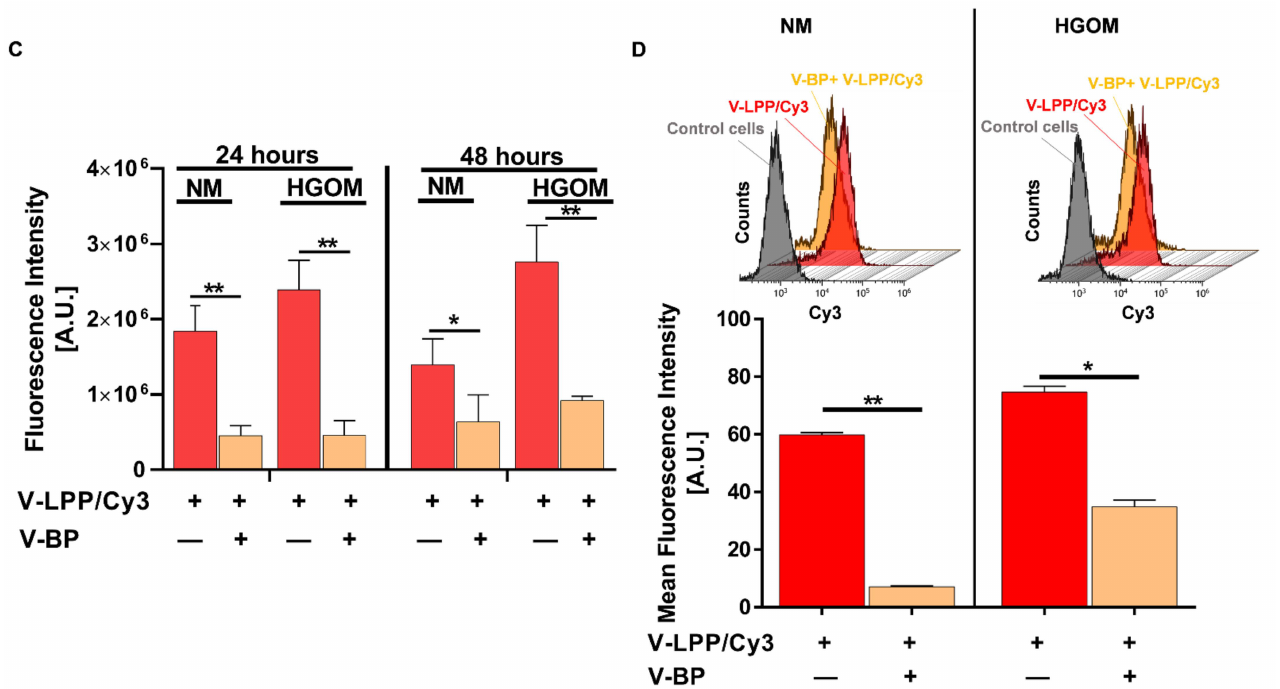
Figure 4. ( A ) VCAM-1 expression on VIC surface. Percentages of VCAM-1 positive cells as de- termined by flow cytometry experiments on VIC cells cultured in normal medium (NM) or high glucose osteogenic medium (HGOM) for 1, 2, or 7 days and plotted from a representative experiment performed in duplicate. The bar graph shows data as mean ± S.D. The overlays of representative flow cytometry histograms are presented above the graphs. ( B ) Fluorescence microscopy exemplifying the uptake of V-LPP/Cy3 labeled plasmid by VIC exposed to NM or HGOM for 5 days before incubation with lipopolyplexes for 24 and 48 h in the absence or the presence of an excess of V-BP (V-LPP/Cy3 (red); scale bar: 100 µ m). ( C ) Quantification of lipopolyplexes uptake expressed as fluorescence intensity of red pixels percentage for each image field (each point represents media of 6 fields) using ImageJ software. The bar graph shows results as mean ± S.D. ( D ) Flow cytometry data showing the uptake of V-LPP/Cy3 labeled plasmid by VIC exposed to NM or HGOM for 5 days before incubation with lipopolyplexes for 48 h in the absence or the presence of excess V-BP. The results are determined as Mean Fluorescence Intensity (MFI) and plotted from a single experiment using triplicate probes. Representative flow cytometry charts are shown above the graph. Statistical significance: * p < 0.05, ** p < 0.01, *** p <